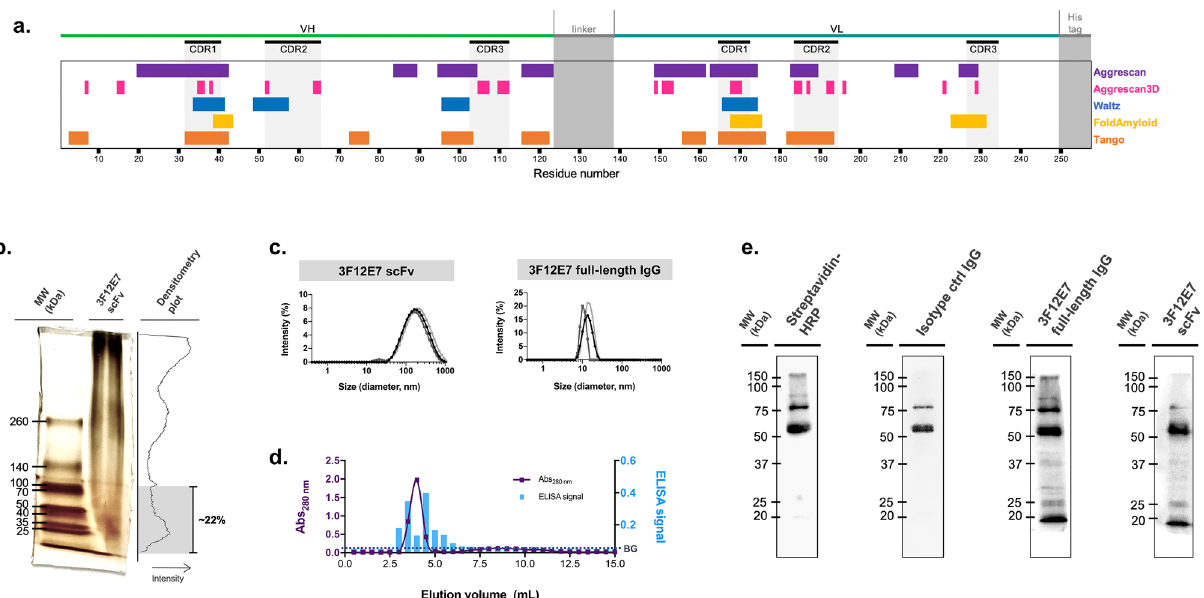
Figure 3. Analysis of the 3F12E7 scFv aggregation state and activity. ( a ) Evaluation of aggregation propensity of 3F12E7 scFv using Aggrescan3D web server and sequence-based predictors. Amino acid residues (numbered according to primary structure) that had positive scores are indicated in different colors for each predictor: Aggrescan (purple); Aggrescan3D (magenta); Waltz (blue); FoldAmyloid (yellow); Tango (orange). ( b ) Oligomeric profile of the 3F12E7 scFv, as assessed by blue native gel polyacrylamide electrophoresis (BN-PAGE). Gel was stained with silver nitrate. Graph on the right shows the corresponding densitometry analysis. ( c ) Dynamic light scattering (DLS) analysis for 3F12E7 scFv (left) and full-length IgG mAb (right). Average particle size results for each mAb are expressed by signal intensity. Each line denotes data obtained for the 3 independent samples. ( d ) Analysis of 3F12E7 scFv by size-exclusion chromatography (on a PD-10 column) and the binding of the obtained fractions to FGF2, as assessed by ELISA. Dashed line indicates ELISA background signal (BG). ( e ) Immunoblotting analysis of the 3F12E7 scFv reactivity to B16-F10 tumor protein extracts. For that, antibodies were labeled with biotin and detected with horseradish peroxidase (HRP)-streptavidin. These immunoblot images are also provided in Supplementary Fig. S4b. MW, molecular weight